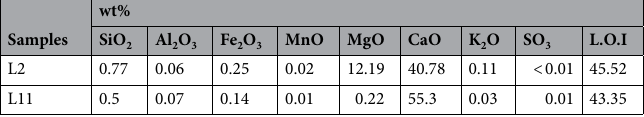
Table 3. Chemical analyses of the selected